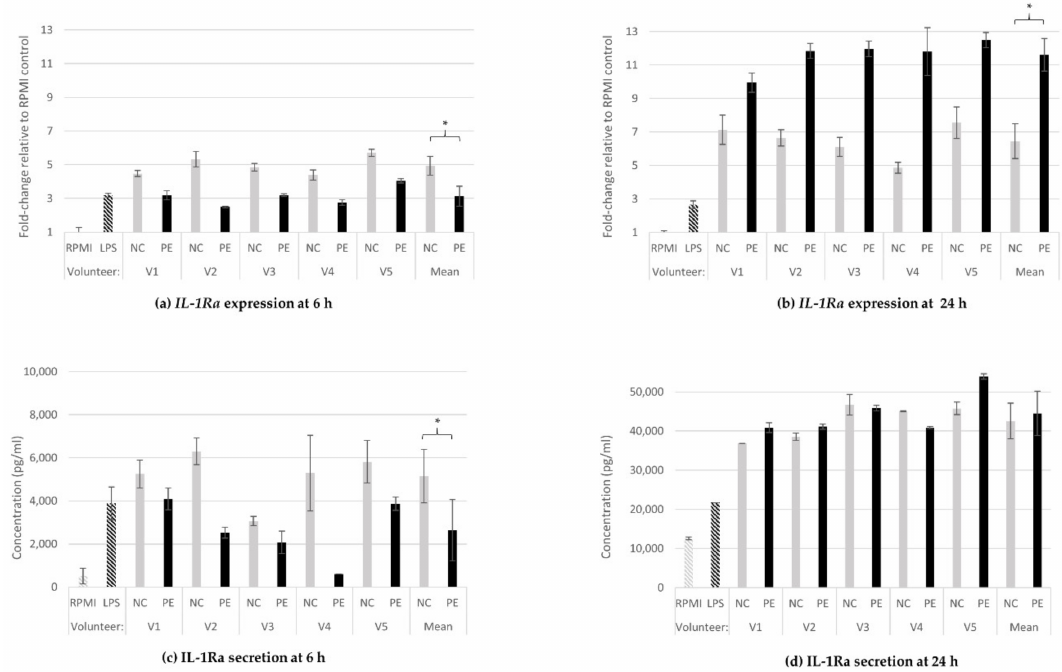
Figure 4. IL-1Ra gene expression and protein release. Relative gene expression of IL-1Ra at 6 h ( a ) and 24 h ( b ) of treatment of U937-derived macrophages with FSs, and IL-1Ra concentration in supernatants of the same cells at 6 h ( c ) and 24 h ( d ). Gene expression is exhibited as fold-change of the value in the untreated cells (RPMI) and relative towards GAPDH expression ( ∆∆ Ct) for all samples ( a , b ). The concentration of the cytokine is expressed in pg/mL of the cell culture supernatants ( c , d ). Data shown are the means and standard deviation (SD bars) from two technical measurements. Asterisks indicate statistical significance as shown by paired-samples t -test, with * p < 0.05.